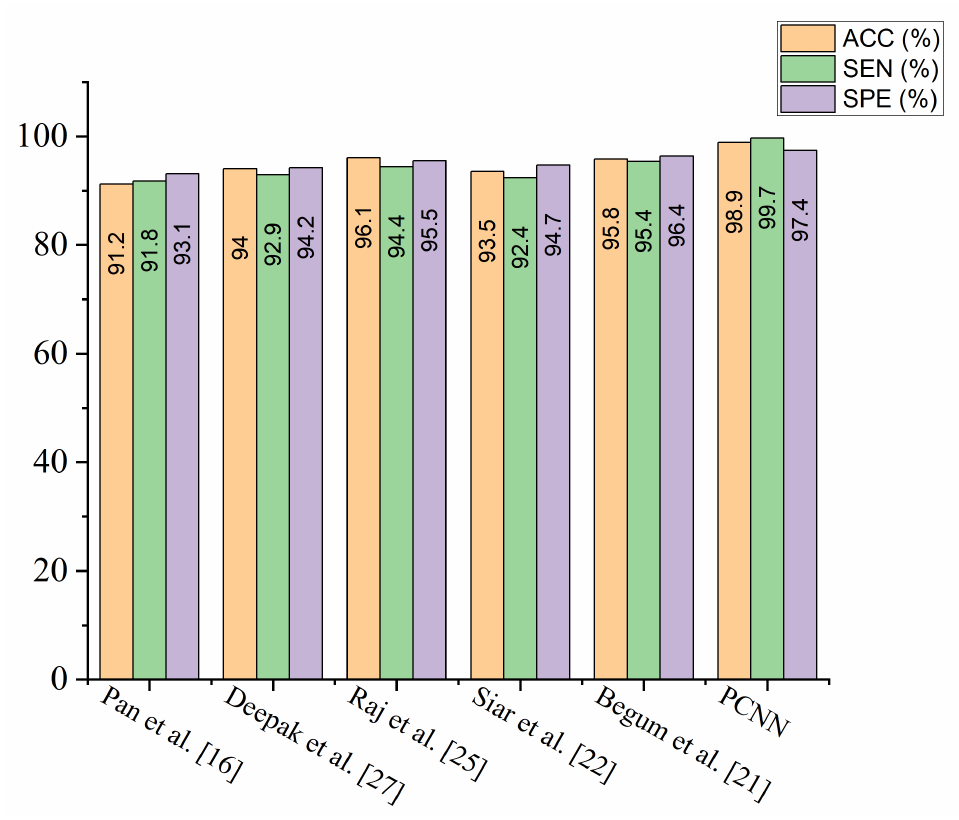
Figure 9. Performance of the proposed PCNN in comparison with some selected state of the art models using the same dataset. Table 4. Result comparison of the proposed PCNN model with state-of-the-art methods for brain tumor classification.